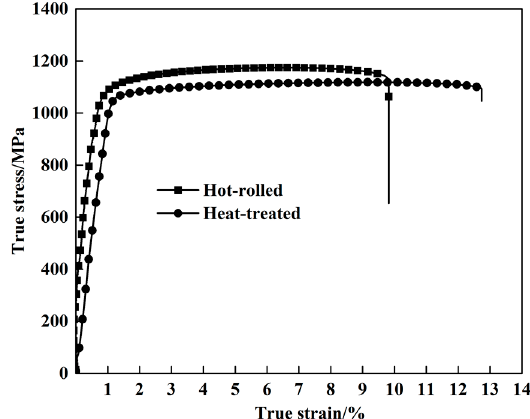
Figure 7. Quasi-static true stress–strain curves of the hot-rolled and heat-treated titanium alloys.